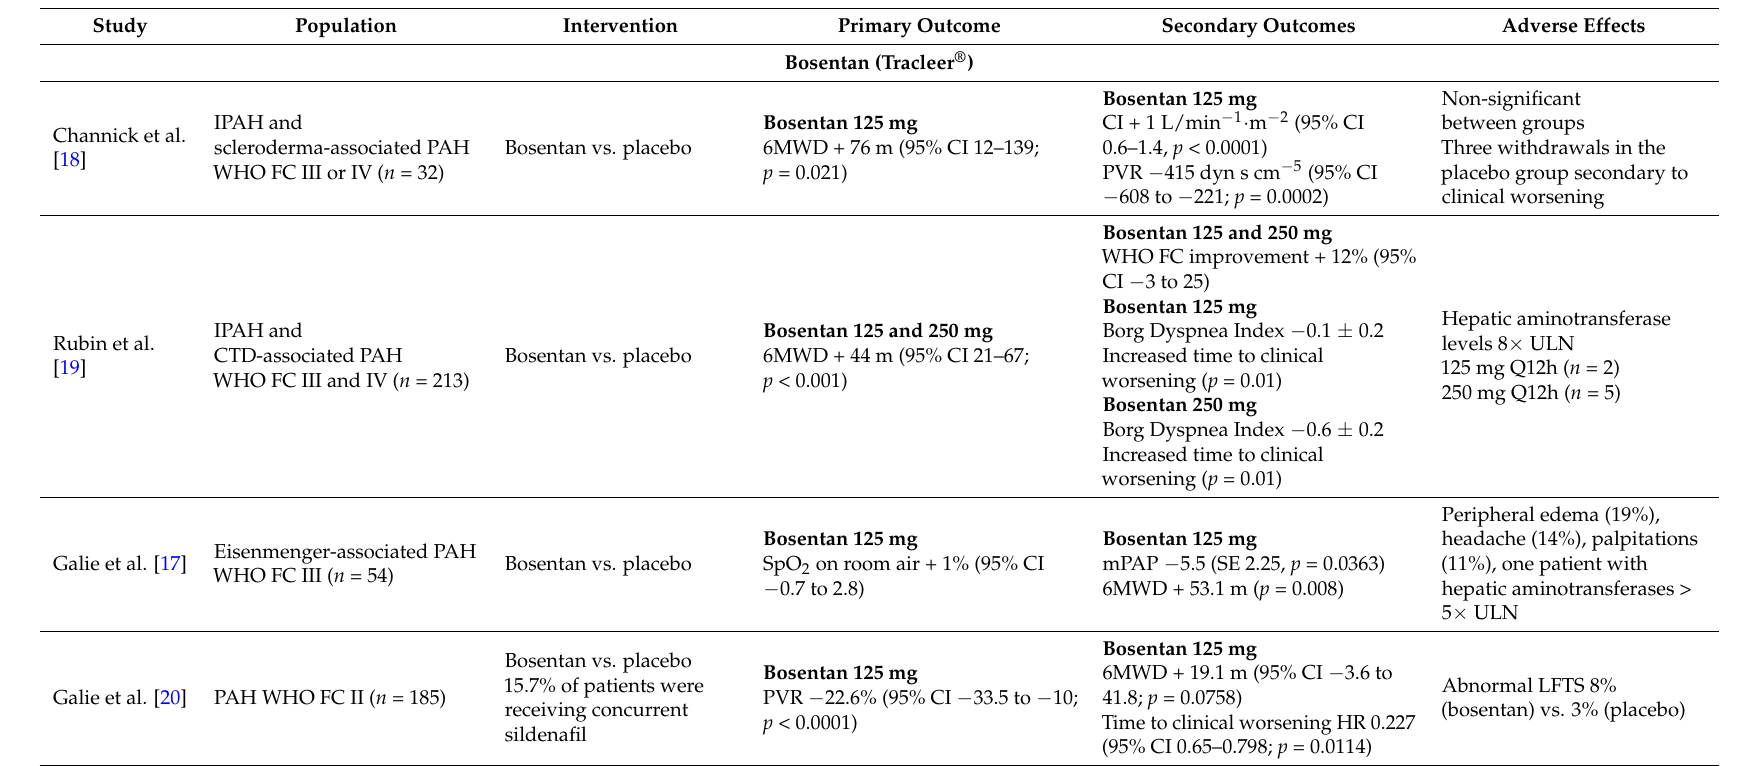
Table 3. Endothelin Receptor Antagonists Clinical